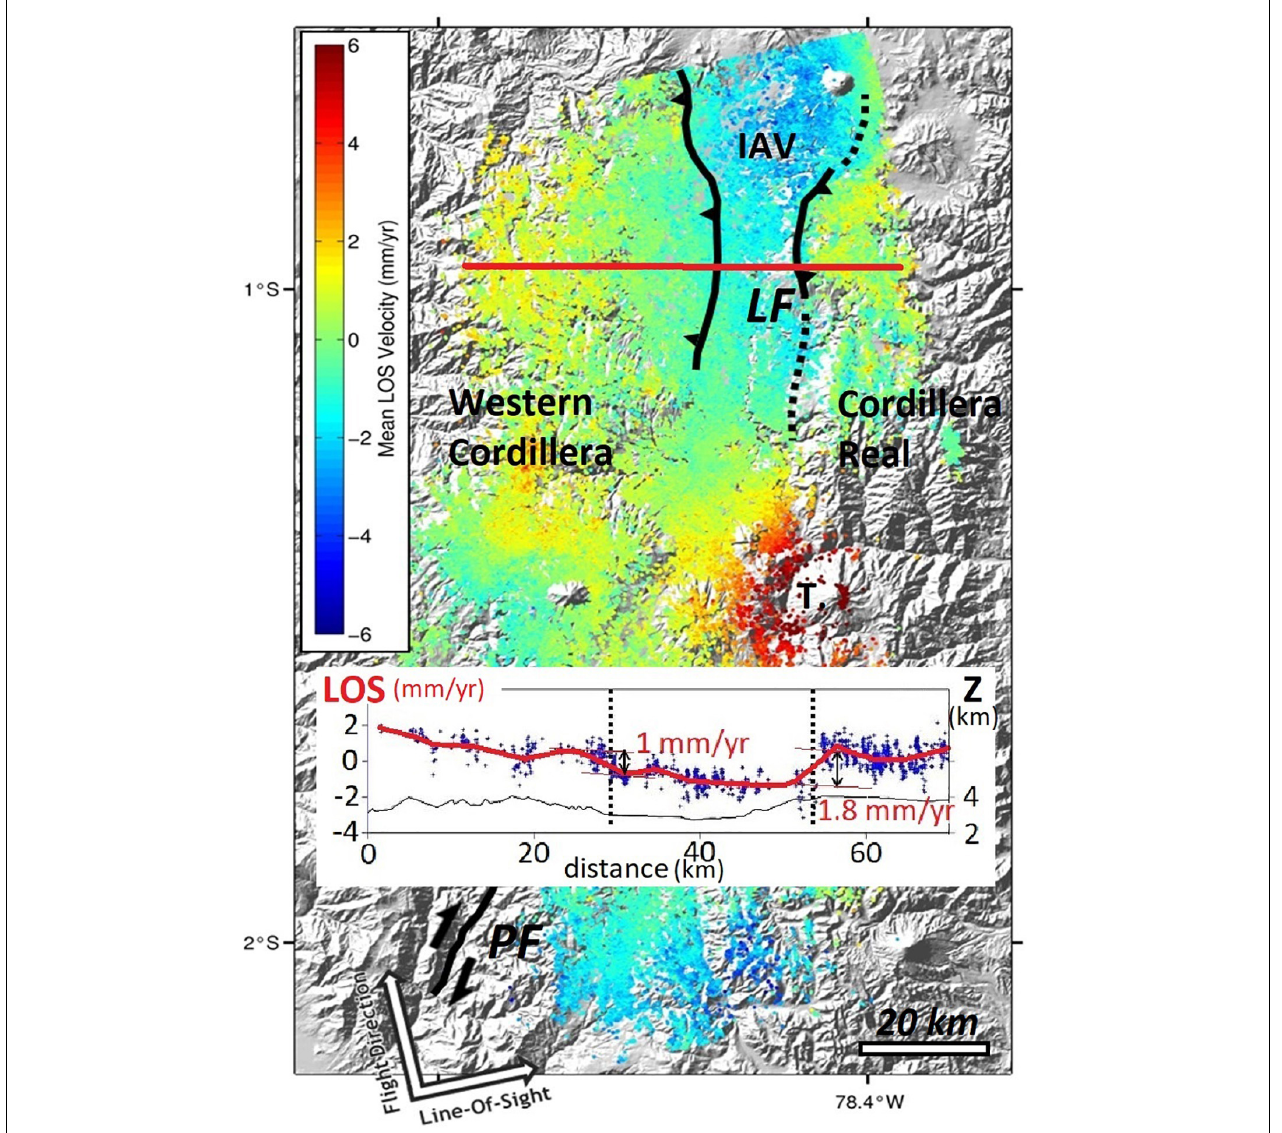
FIGURE 11 | Illustration of surface deformation in the Inter-Andean Valley seen by SAR geodesy. The gentle decrease in the Line-Of-Sight displacement rate (LOS, in mm/yr) toward the east (due to the interseismic loading because of the subduction convergence) is affected by two sharper gradients in displacement rate that could match with the two IAV-bounding fault zones (Alvarado, 2012) that cause the uplift of the Cordilleras. Posing several assumptions (see text), we estimate that the fault slip rates could reach 1.7 mm/yr and 0.5 mm/yr for the Eastern and Western Boundary Faults, respectively. IAV, Interandean valley; LF, Latacunga folds; PF, Pallatanga fault; T., Tungurahua